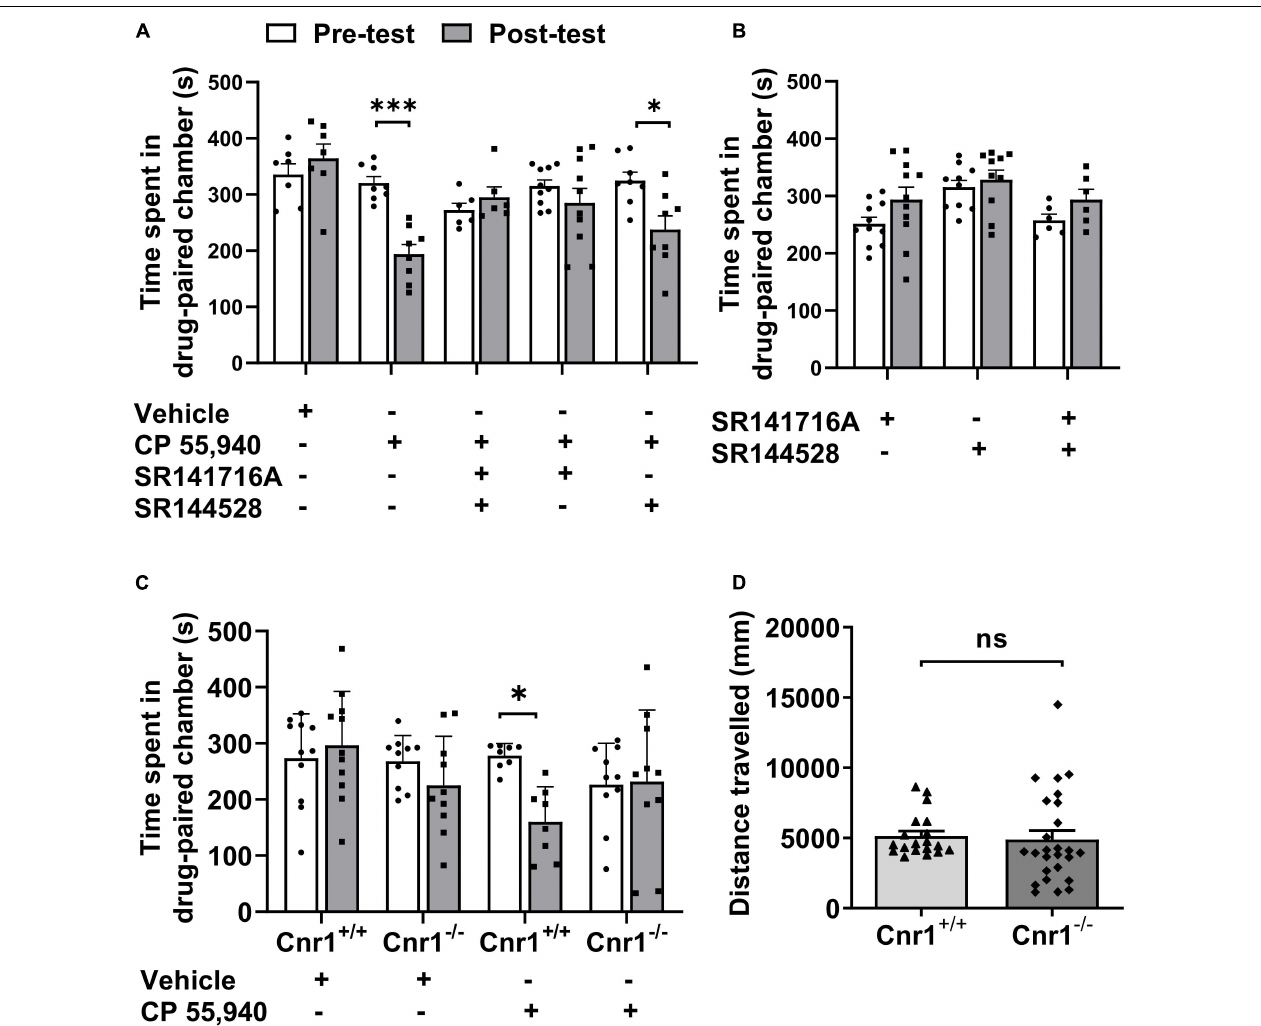
FIGURE 2 | CP 55940-induced conditioned place aversion is prevented by the antagonism or systematic deletion of CB1 receptors. (A) Effects of antagonists of CB1R and CB2R (SR141716A and SR144528, respectively) on CP 55,940 conditioning. (B) Conditioning with SR141716A and SR144528 alone or in combination showed no place preference. (C) Effects of CB1R knockout on CP 55,940 conditioning. ∗ P < 0.05, ∗∗∗ P < 0.001 (one-way ANOVA, Welch and Brown–Forsythe test). (D) Distances traveled in the conditioned place preference apparatus for Cnr1 + / + ( n = 19) and Cnr1 - / - mice ( n = 26). ns, not statistically significant (Student’s unpaired t